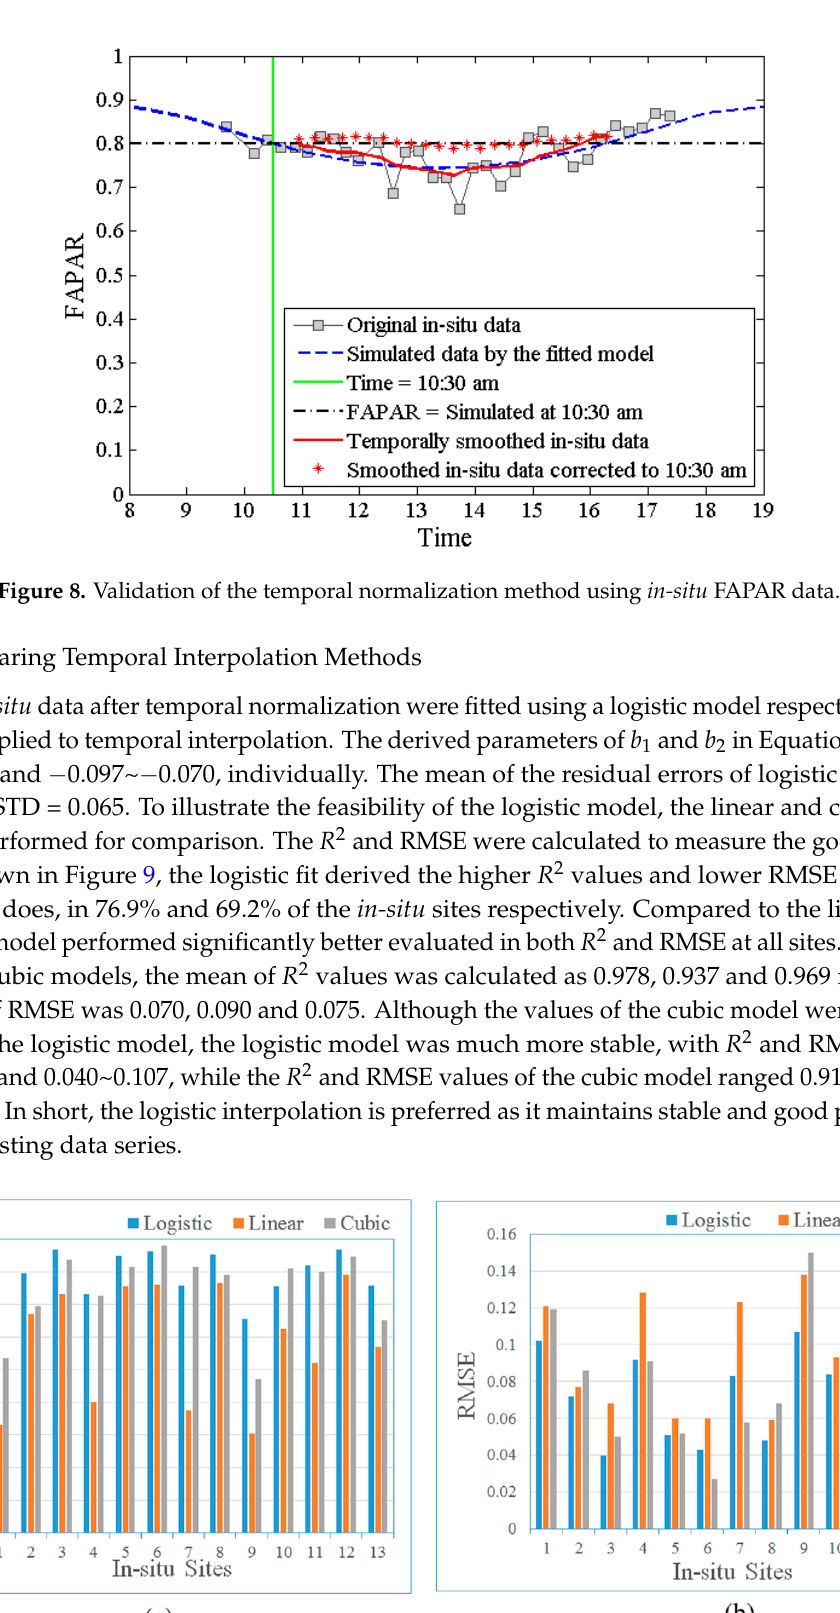
Figure 7. Sensitivity of FAPAR correction to random noises in input LAI and FAPAR measurement under VIS = 30 km given FAPAR = (1% ± 20%) of the truth FAPAR at different SZAs and: